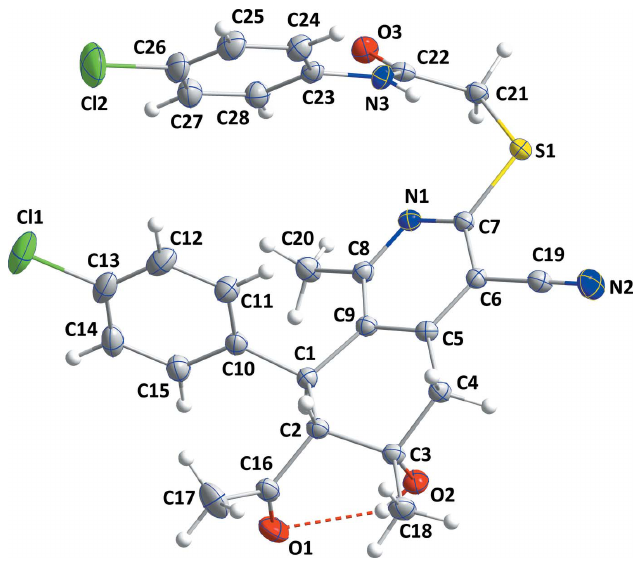
Figure 1 The title molecule with the labeling scheme and 50% probability ellipsoids. The intramolecular O—H (cid:2)(cid:2)(cid:2) O hydrogen bond is depicted by a dashed